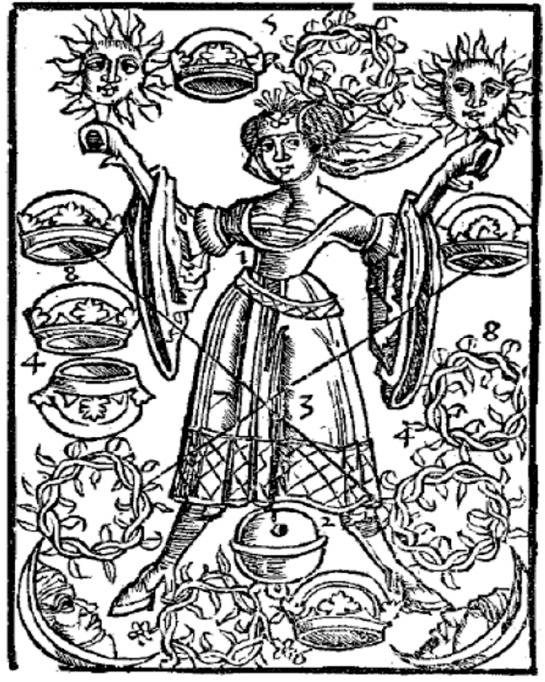
Figure 4. The Square of Opposition.